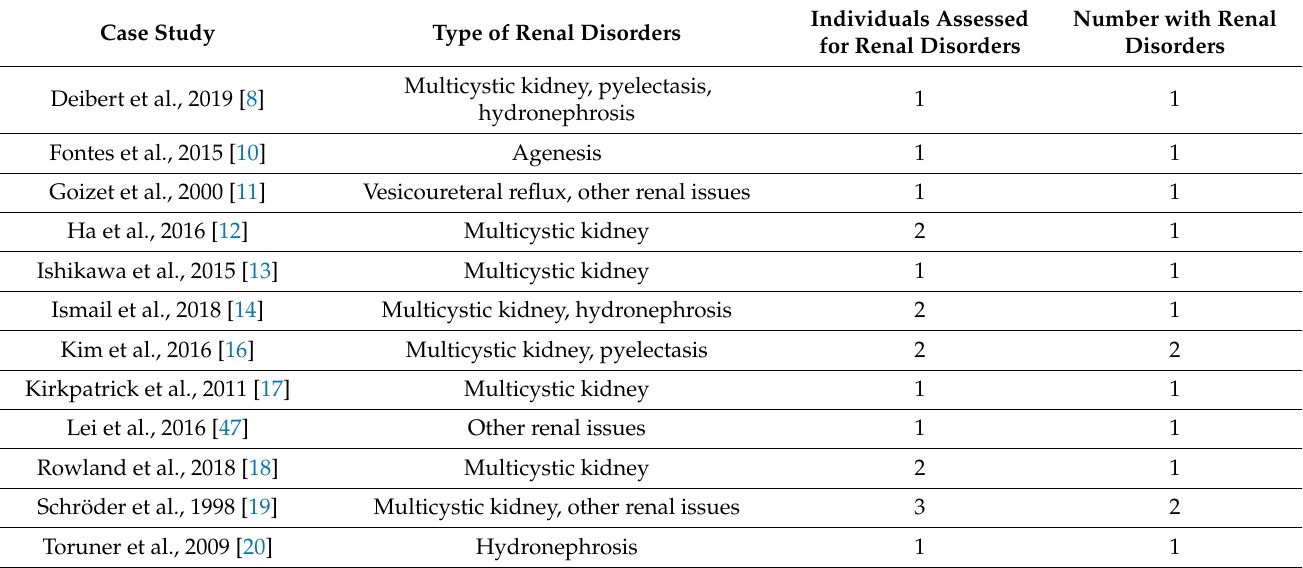
Table 2. Summary of kidney disorders found in Phelan-McDermid syndrome case studies.